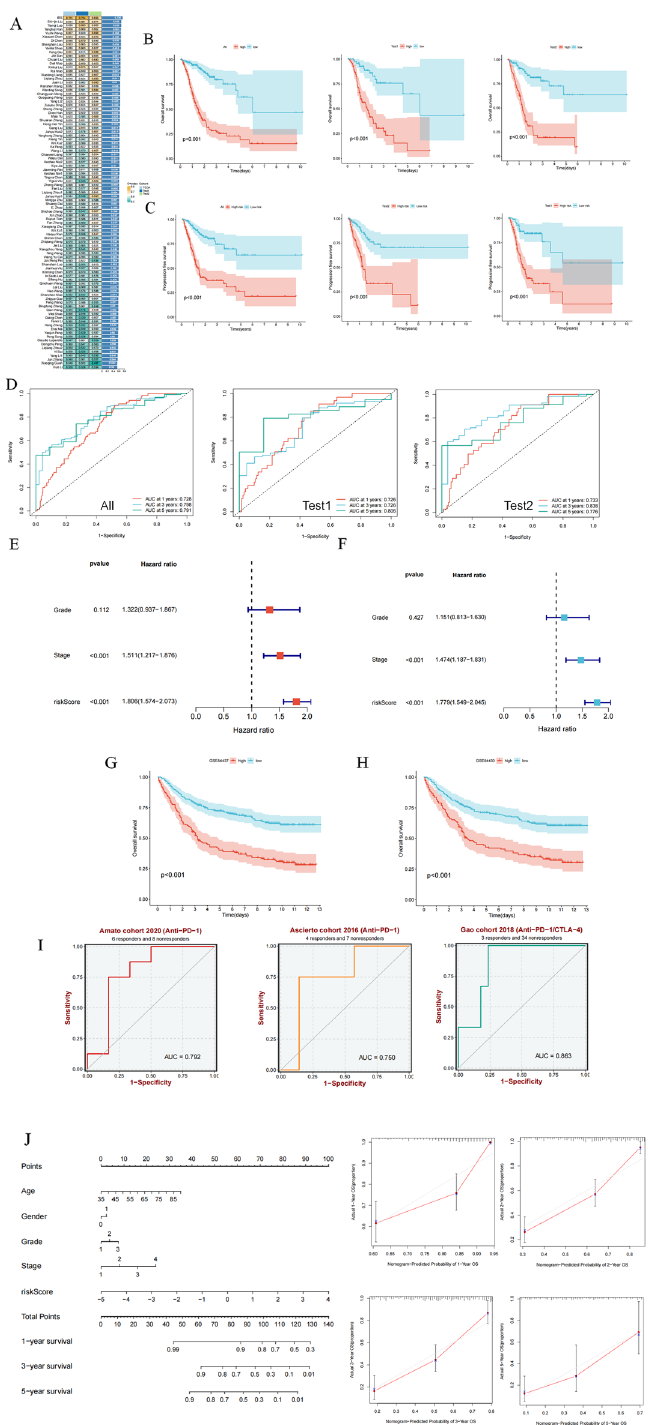
Figure 4. Analysis of the accuracy and validity of IRS. ( A ) C-index values of IRS compared with 93 published prognostic models for gastric cancer. The results demonstrate the outperformance of IRS over published signatures ( B ) OS analysis of IRS in the total cohort, test1 cohort, and test2 cohort. Poorer prognosis for high- risk patients compared to low-risk patients. ( C ) PFS analysis of IRS in the total cohort, test1 cohort, and test2 cohort. Poorer prognosis for high-risk patients compared to low-risk patients. ( D ) 1, 3, and 5 year ROC analysis of IRS in total cohort, test1 cohort, and test2 cohort. ( E ) Univariate Cox regression analysis of IRS and clinical characteristics. ( F ) Multivariate Cox regression analysis of IRS and clinical characteristics. ( G ) OS analysis of IRS in GSE84437. ( H ) OS analysis of IRS in GSE84433. ( I ) ROC analysis of IRS differentiating between responding and non-responding patients in an immunotherapy cohort. IRS has predictive value for patient response to immunotherapy. ( J ) Risk scores combined with clinical characteristics of the nomogram. The calibration curve proves the accuracy of this